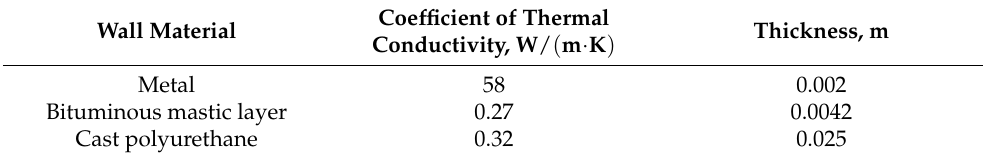
Table 1. Wall parameters.